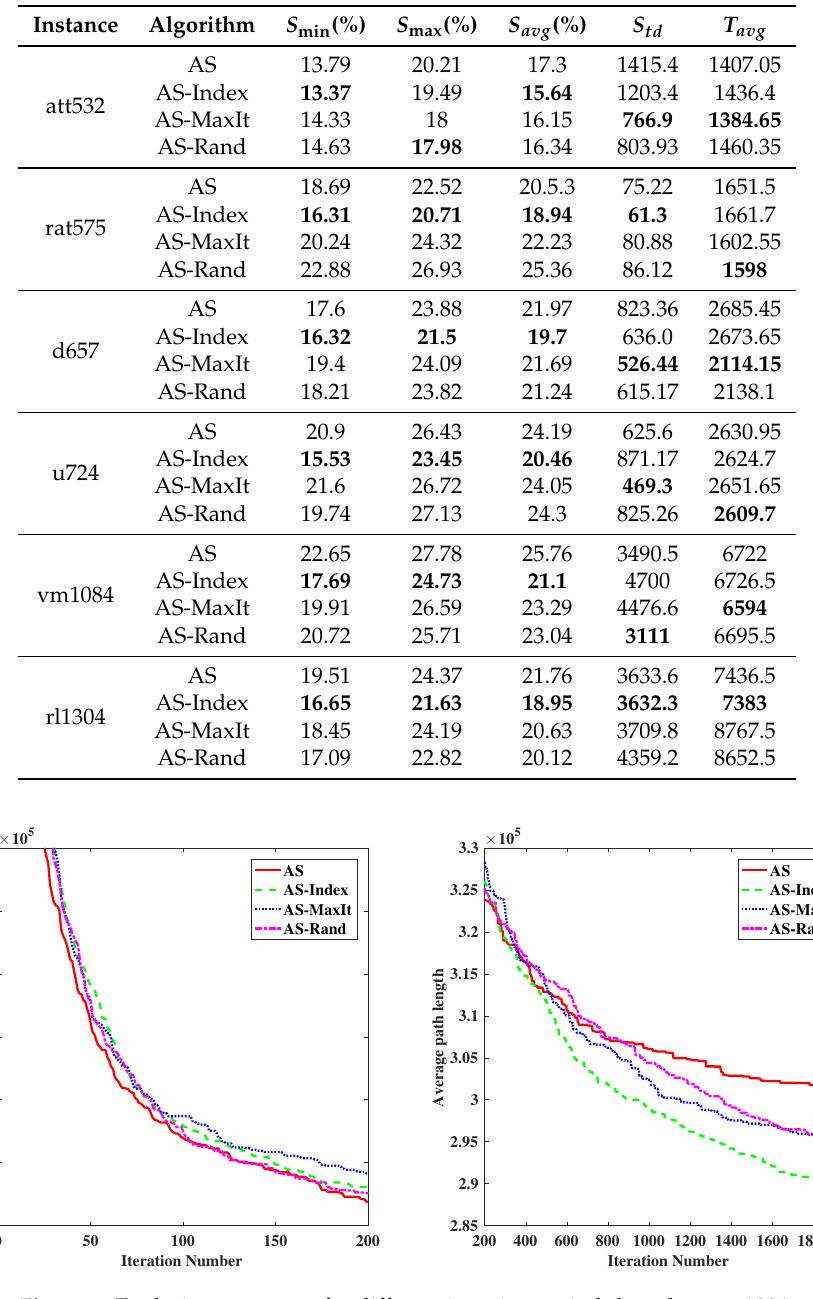
Table 3. Results comparison for large-scale example sets.